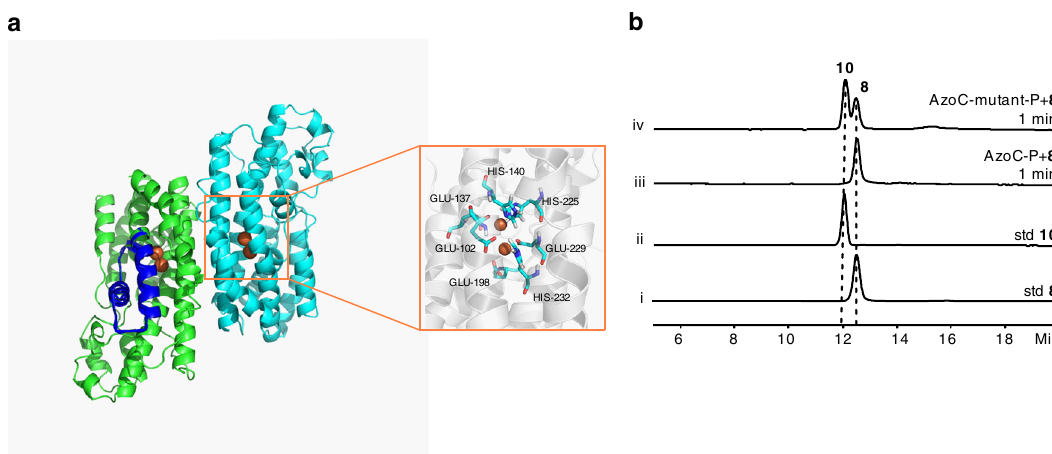
Fig. 4 In silico model of AzoC and reconstitution of nucleophilic activity of AzoC via sequence shuf fl ing. a Structure model of AzoC. The iron atoms are shown as brown spheres. The two iron ions are coordinated with protein residues Glu-102, Glu-137, His-140, Glu-198, His- 225, Glu-229, and His-232.The mutated sequence of AzoC-mutant is shown as a blue ribbon. b HPLC analysis of AzoC-P and AzoC-mutant-P ’ s in vitro biochemical reactions at 345 nm. Reactions were performed in 20 mM HEPES buffer (pH 7). (i) Standard 8 , (ii) standard 10 , (iii) 8 with eq AzoC-P for 1 min, (iv) 8 with eq AzoC-mutant-P for 1